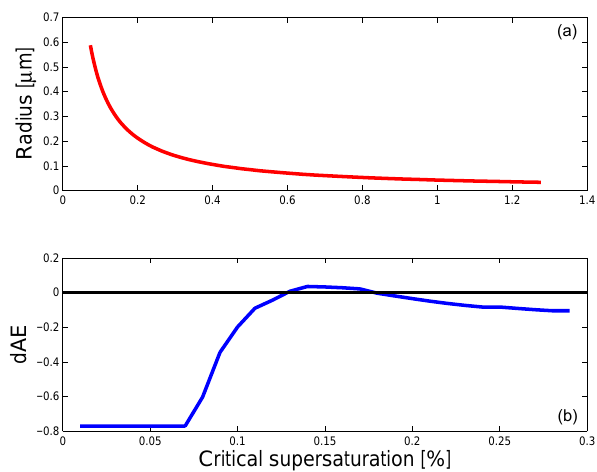
Figure 6. Critical cloud droplet activation radius as a function of critical supersaturation (a) and estimated difference in AE, between cloudy- and clear-sky case (b) .